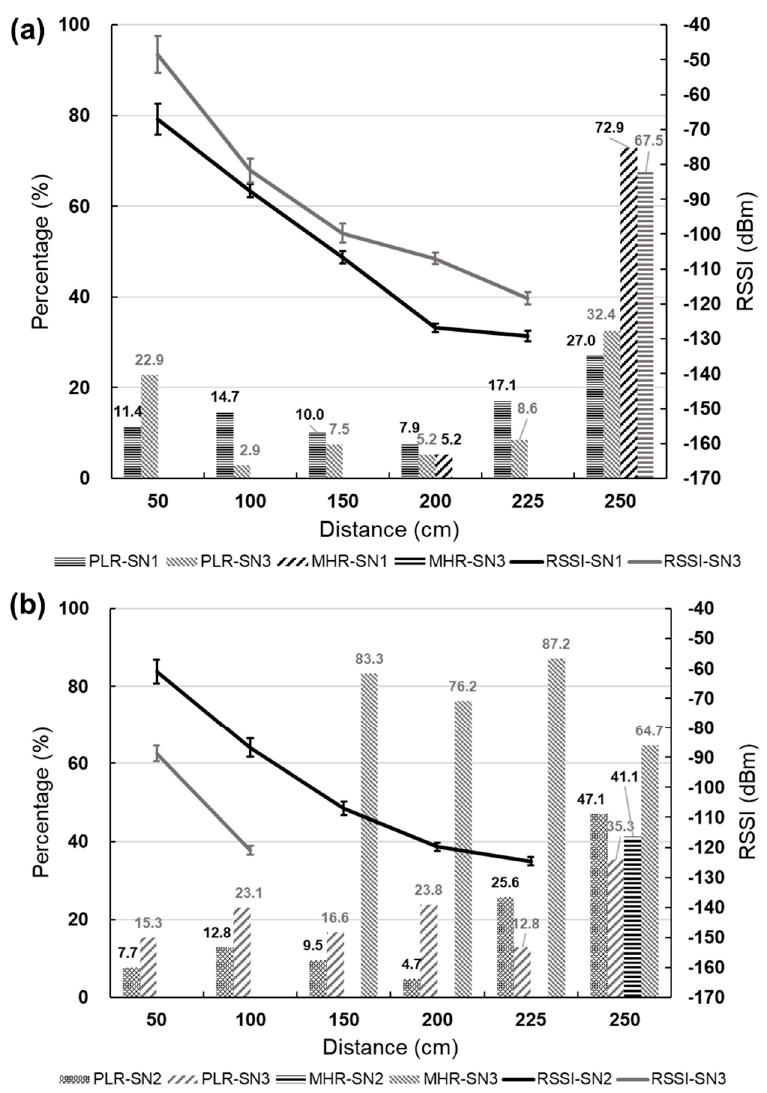
Figure 7. Multi-hop underground transmission test: ( a ) transmission status of SN2 to SN1 and SN3; ( b ) transmission status of SN1 to SN2 and SN3 (when RSSI information is not recorded after the multi-hop